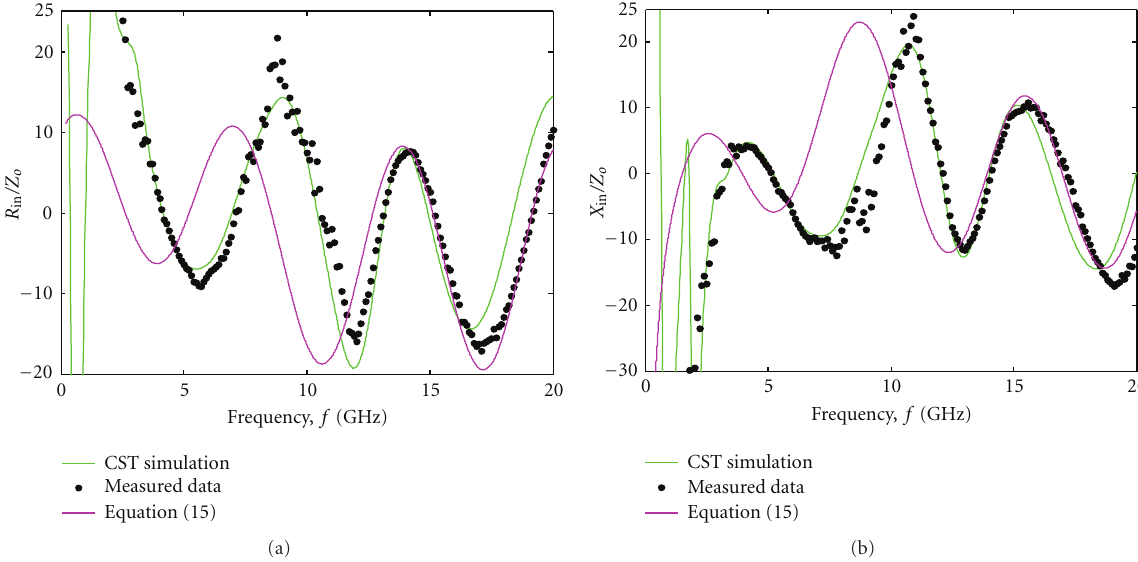
Figure 11: Comparison of (a) normalized resistance, R in /Z o , and (b) normalized reactance, X in /Z o , of the coupling monopole at parasitic port-2 ( a = 0 . 65 mm, b = 2 . 05mm, h 1 = h 2 = 14 . 32 mm, and D =